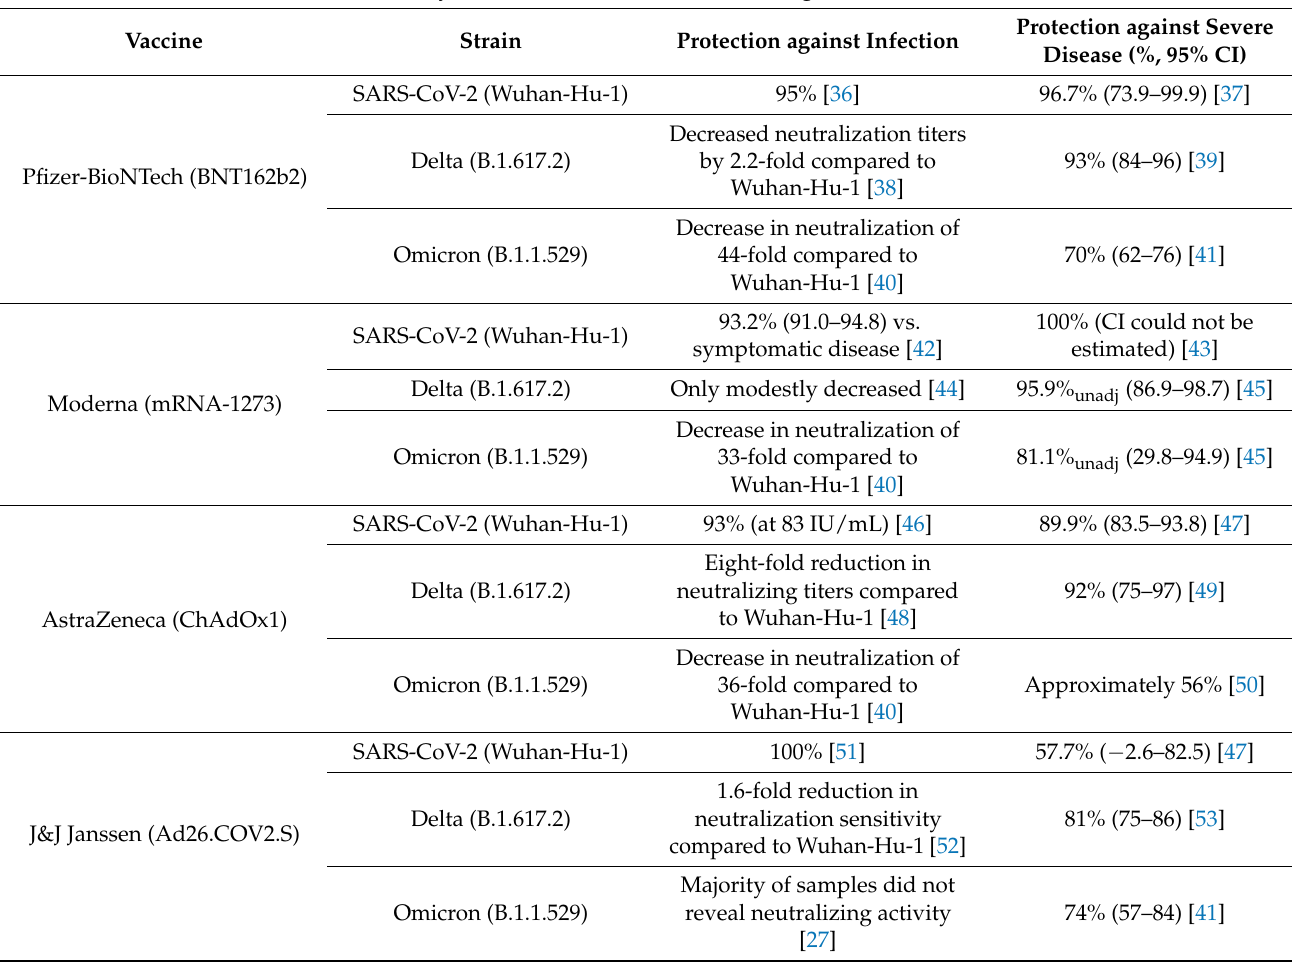
Table 1. Efficacy of the COVID-19 vaccines in protecting against infection and severe disease caused by VOCs. Despite impaired protection against infection, protection against severe disease is main- tained. This might be underpinned by preservation of T-cell responses against the VOCs. Efficacy of the First-Generation Vaccines against